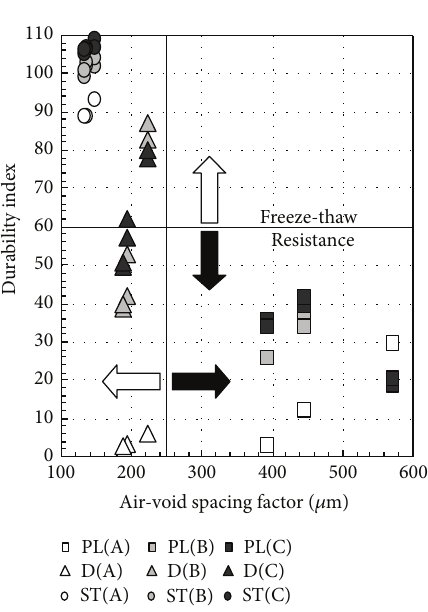
Figure 14: Relationship between air void spacing factor and dura- bility index.